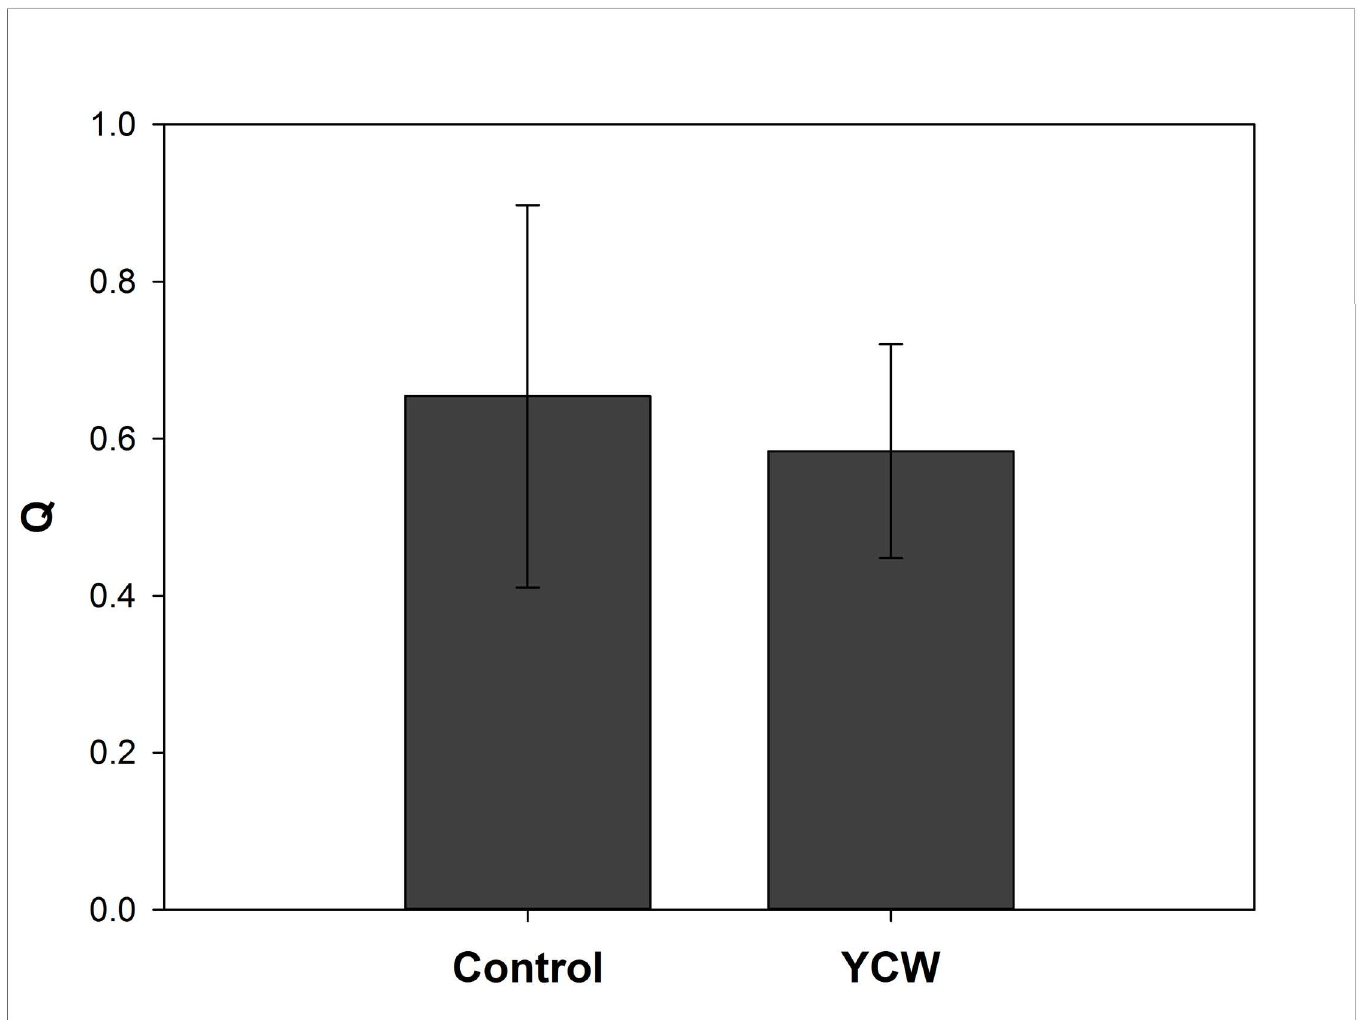
Fig 5. Effect of dietary YCW extractson calrl expression in the gut of Atlantic salmon during Trial#1. Fish were fed either a control diet (Control) or the same base diet supplemented with 0.4% YCW. Expression is given as a ratio of the arbitrary unit for CALRL to the arbitrary units of two reference genes, elongationfactor 1-alphaand beta-actin.Data are present as Means ± SEM (n = 6). The expressionof CALRL is not significantly different betweendiets (p > 0.05), as established by independent sample t-test after checkingfor normality and